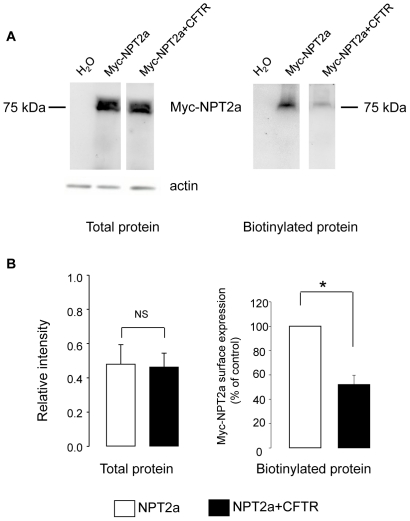
Immunodetection of Myc-NPT2a protein expressed in Myc-NPT2a- and Myc-NPT2a+CFTR-oocytes.
A
: Myc-NPT2a expression in Myc-NPT2a- and Myc-NPT2a+CFTR-oocytes (total or biotinylated proteins) was analyzed by Western blot using a polyclonal Myc antibody. H2O-injected oocytes were used as control. Actin expression was used as loading control of total proteins. The molecular weight of Myc-NPT2a is indicated. B: Left part: Quantification of the staining intensity of Myc-NPT2a in total lysate over the staining intensity of actin from Myc-NPT2a-oocytes (white column) and NPT2a+CFTR-oocytes (black column). Results are expressed as means ± SEM (N = 4). Right part: Quantification of the staining intensity of Myc-NPT2a cell surface expression from Myc-NPT2a+CFTR oocytes (black column) normalized against the staining intensity of Myc-NPT2a cell surface expression from Myc-NPT2a-oocytes. Results are expressed as means ± SEM (N = 4); *: P<0.05.